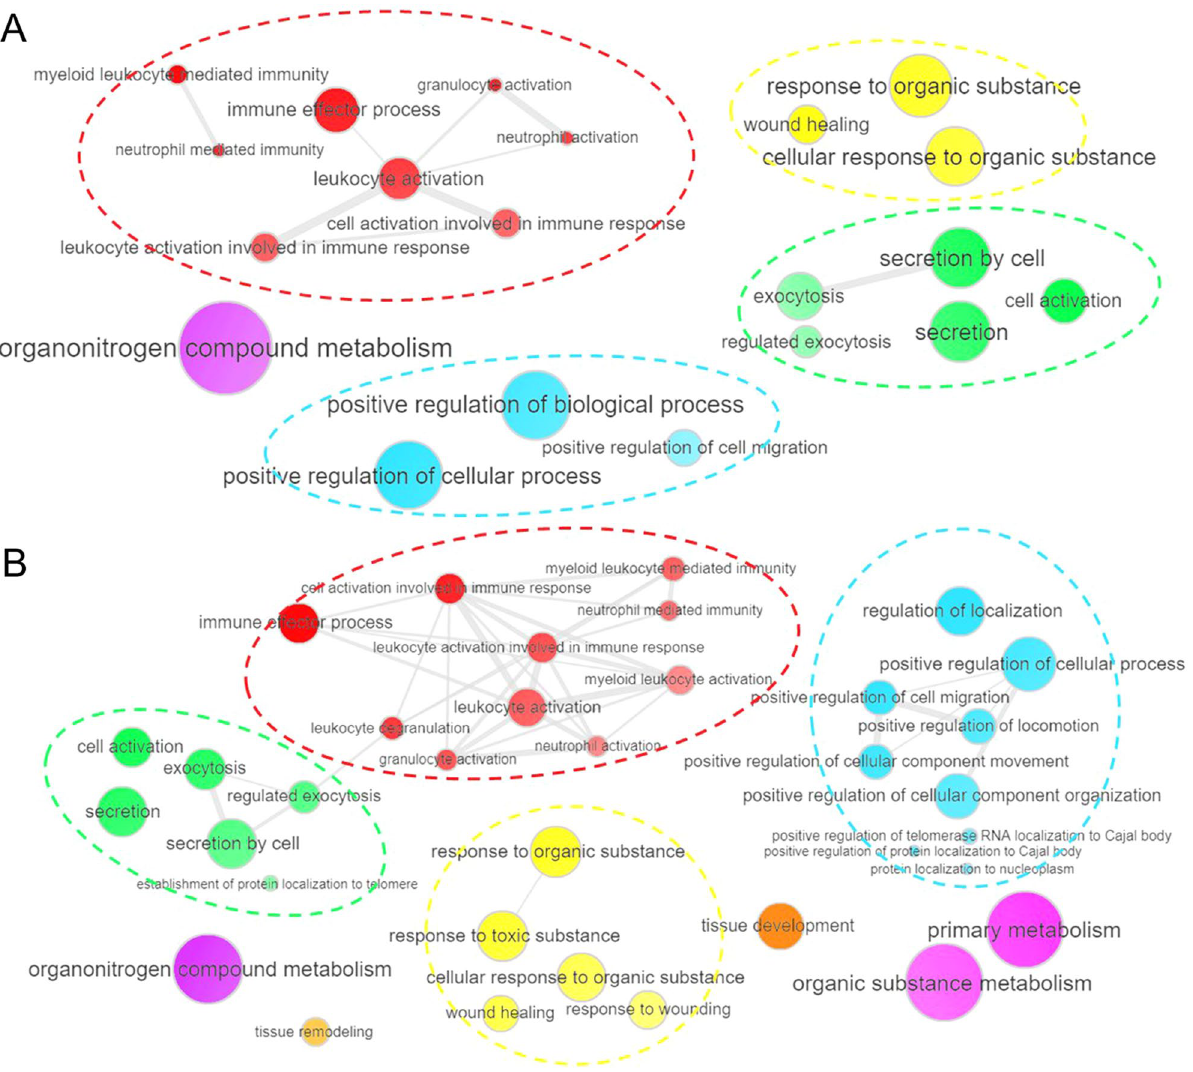
Figure 3. Biological processes associated with medial correlates of flow-sensitive intimal genes. For all the medial genes whose expression correlated with the 18 flow-sensitive, extracellular-coding intimal genes that had > 200 medial correlates, significantly (q-value < 0.05) over-represented GOs were identified using g:Profiler. The diagrams summarize the biological processes terms that were present in > 50% of GOs enriched in ( A ) genes positively correlated with intimal genes exhibiting higher expression in ligated animals compared to sham, and ( B ) genes negatively correlated with intimal genes exhibiting lower expression in ligated animals than in sham. Symbol sizes represent the frequency of the ontology term, and lines between symbols indicate relationships. Groups of closely related terms are denoted by matching color and dashed ellipses. Note that organonitrogen compound metabolism is the largest symbol in ( A ), and one of the largest in ( B ). Both diagrams show multiple terms associated with leukocyte activation/immune responses (red) and secretion/exocytosis (green). Terms related to wound healing and cell movement are also present in both